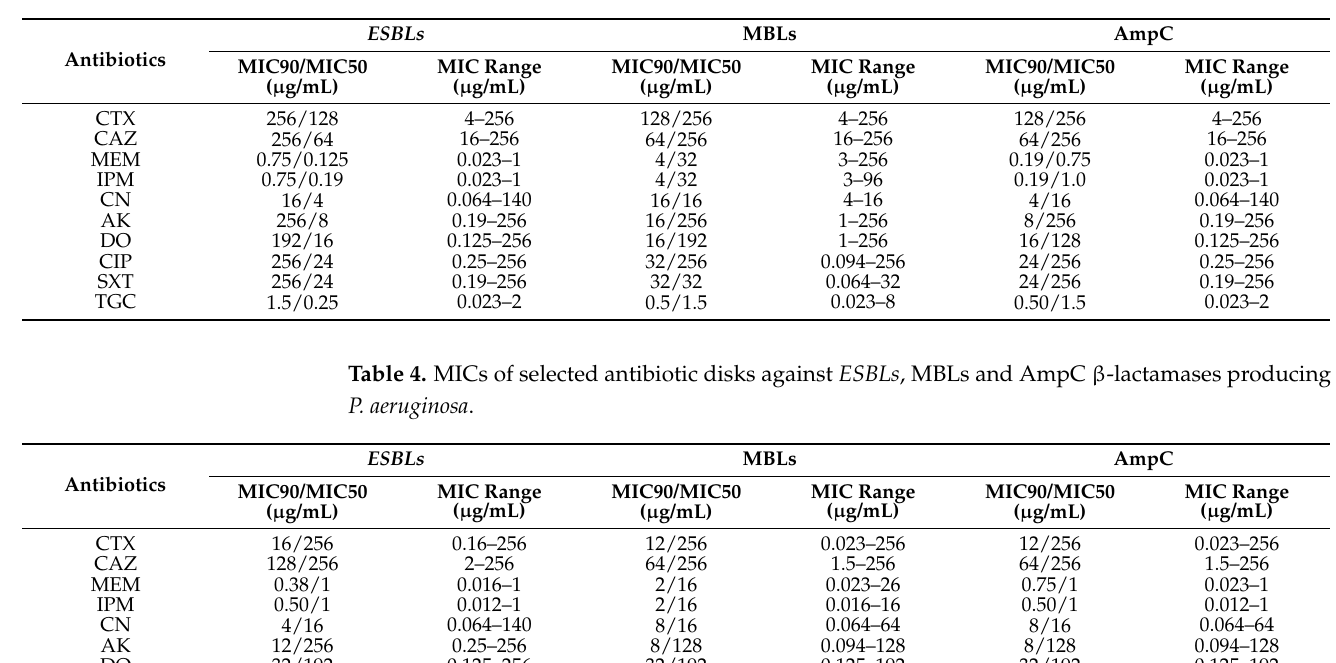
Table 3. MICs of selected antibiotic disks against ESBLs , MBLs and AmpC β -lactamases producing E. coli .